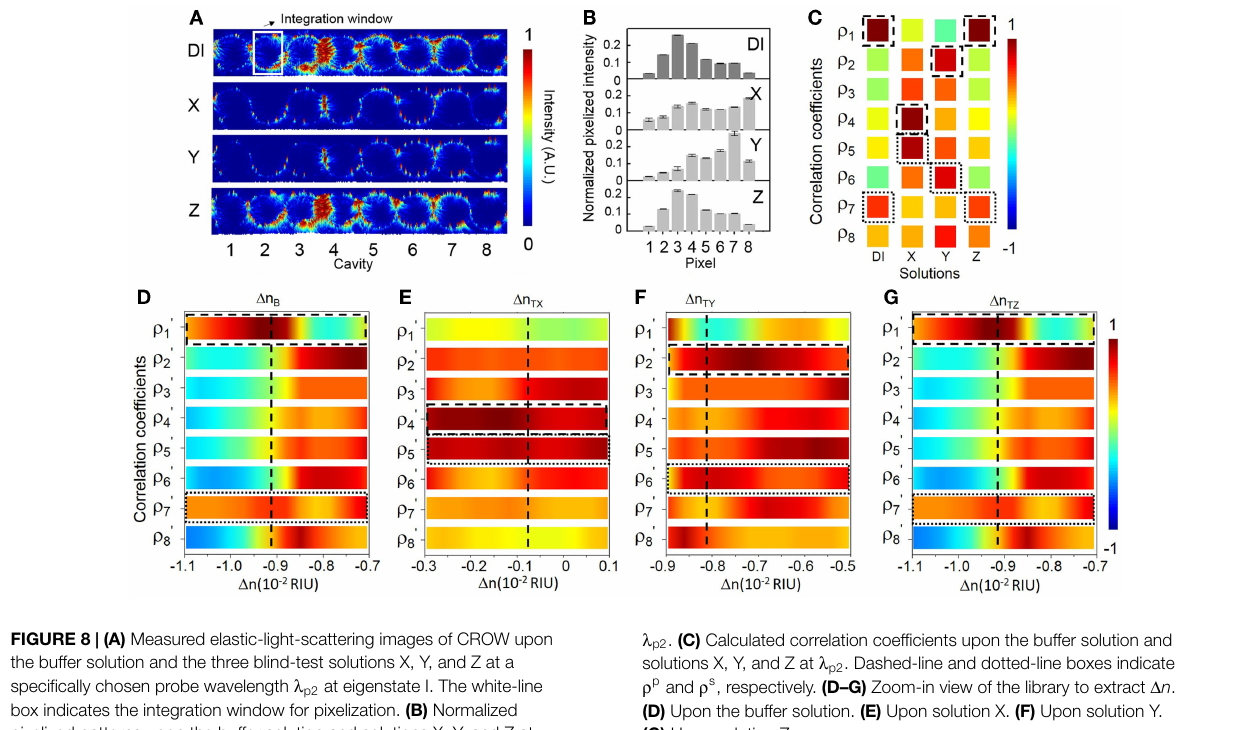
FIGURE 8 | (A) Measured elastic-light-scattering images of CROW upon the buffer solution and the three blind-test solutions X, Y, and Z at a specifically chosen probe wavelength λ p2 at eigenstate I. The white-line box indicates the integration window for pixelization. (B) Normalized pixelized patterns upon the buffer solution and solutions X, Y, and Z at